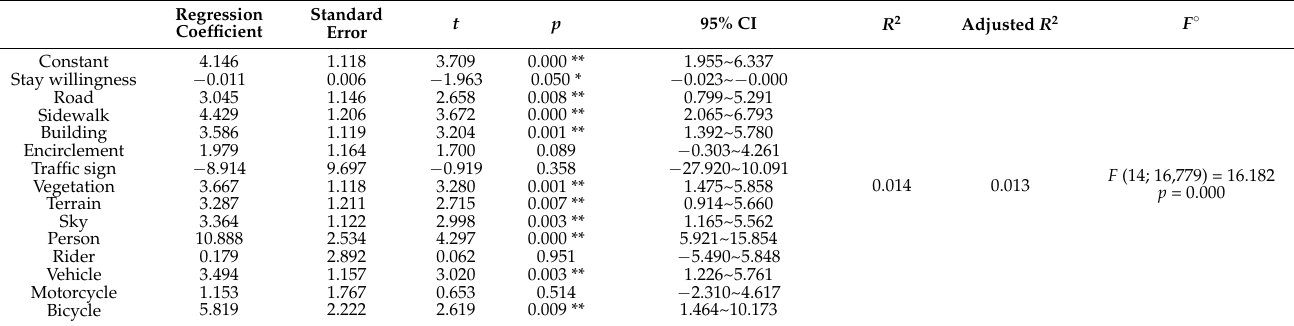
Table 8. OLS analysis with service rating as the dependent variable ( n = 16,794).